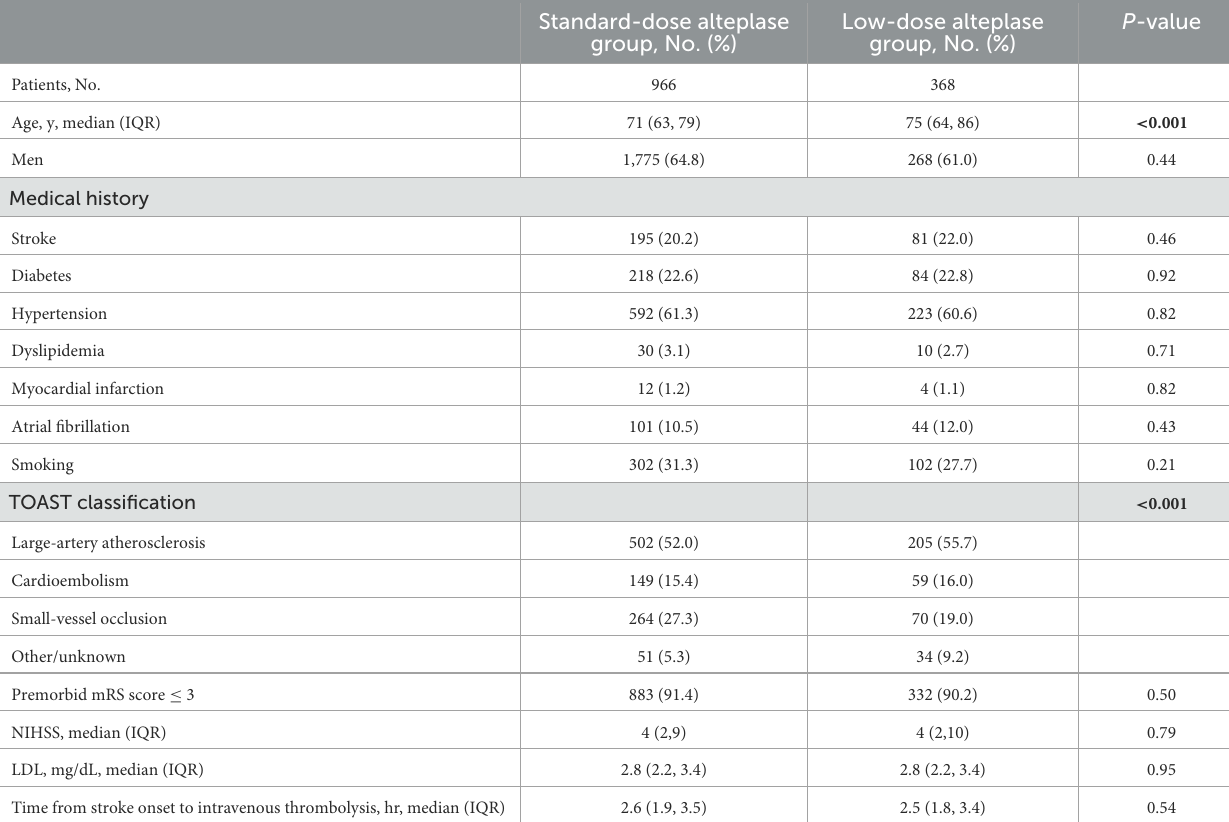
TABLE 1 Baseline characteristics of the patients after propensity score matching.